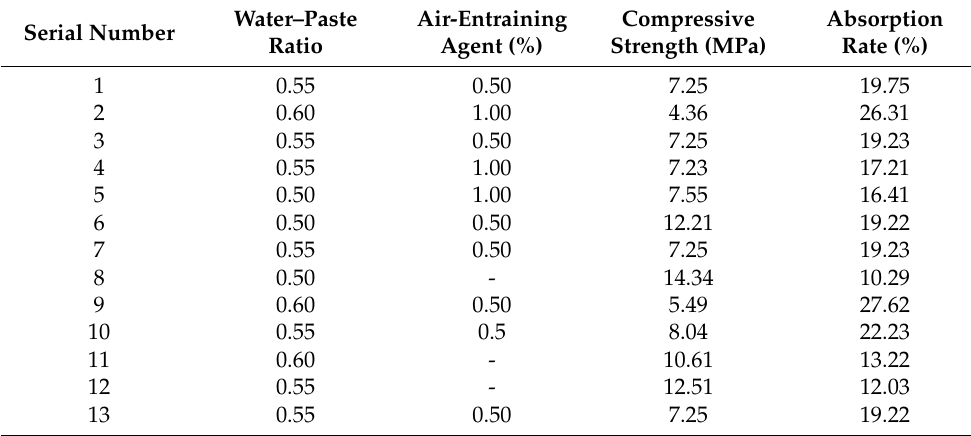
Table 4. Experiment results of the central composite response surface.